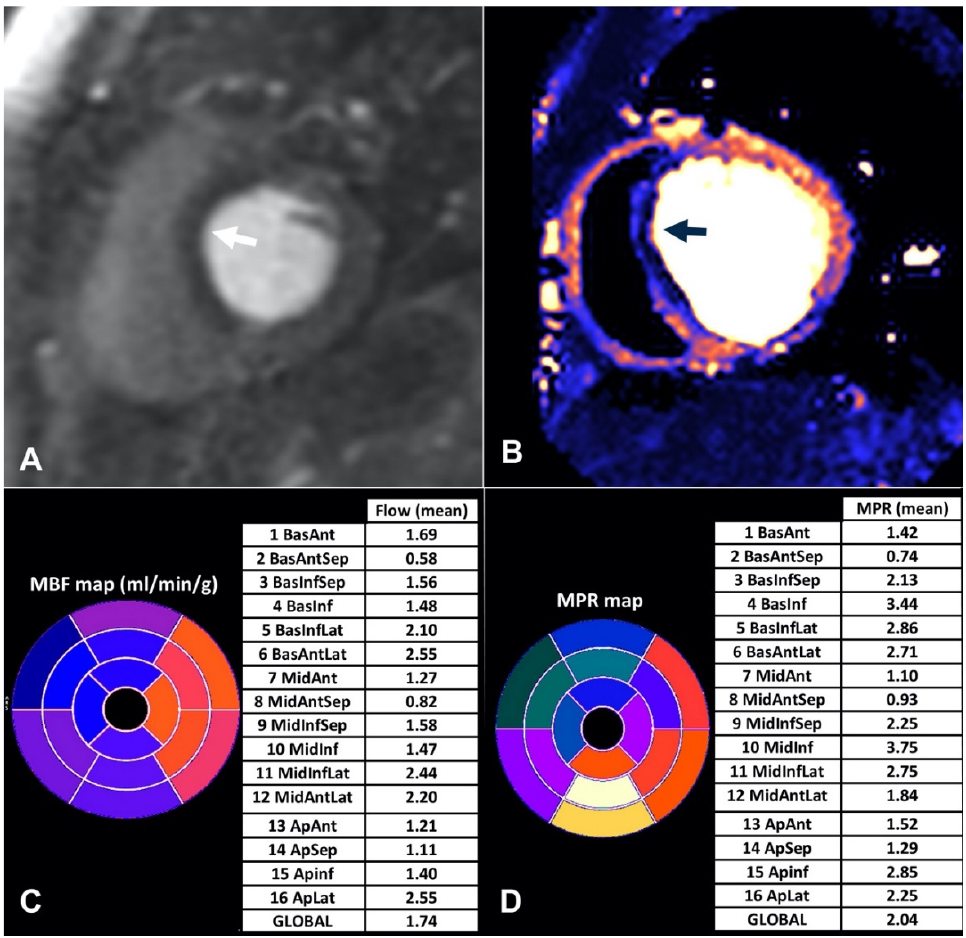
Figure 1. Visual and quantitative analysis of stress myocardial perfusion in a patient with hy- poperfusion in the septum. ( A ) First-pass perfusion images showing a hypointense area in the basal septum (arrow). ( B ) Pixel-wise map of myocardial blood flow map demonstrating the region of low flow in darker color than normal flow (arrow). ( C , D ) Polar maps of myocardial blood flow (MBF) and myocardial perfusion reserve (MPR) demonstrating low values in the left anterior descending coronary artery territory.